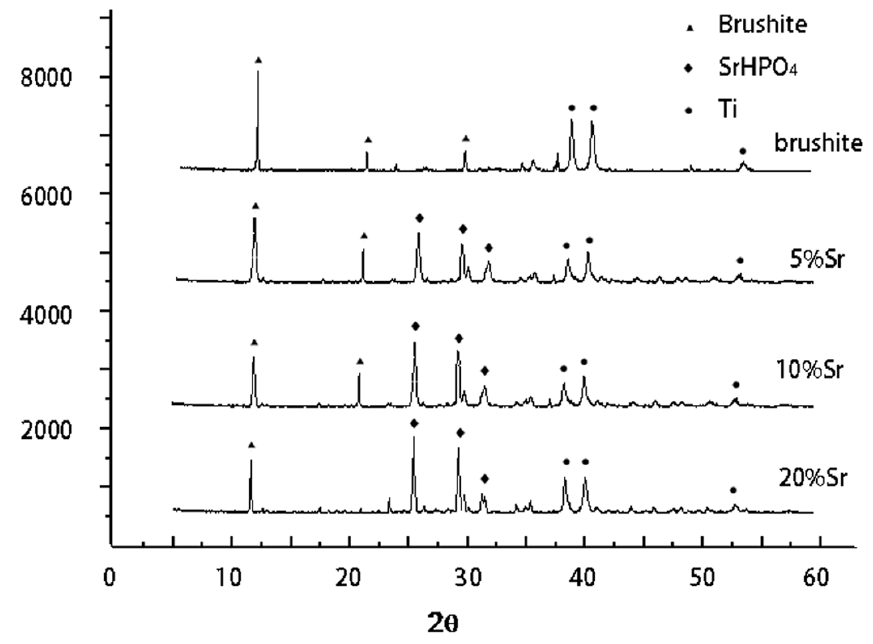
Figure 1. XRD analysis in brushite, 5% Sr, 10% Sr and 20% Sr